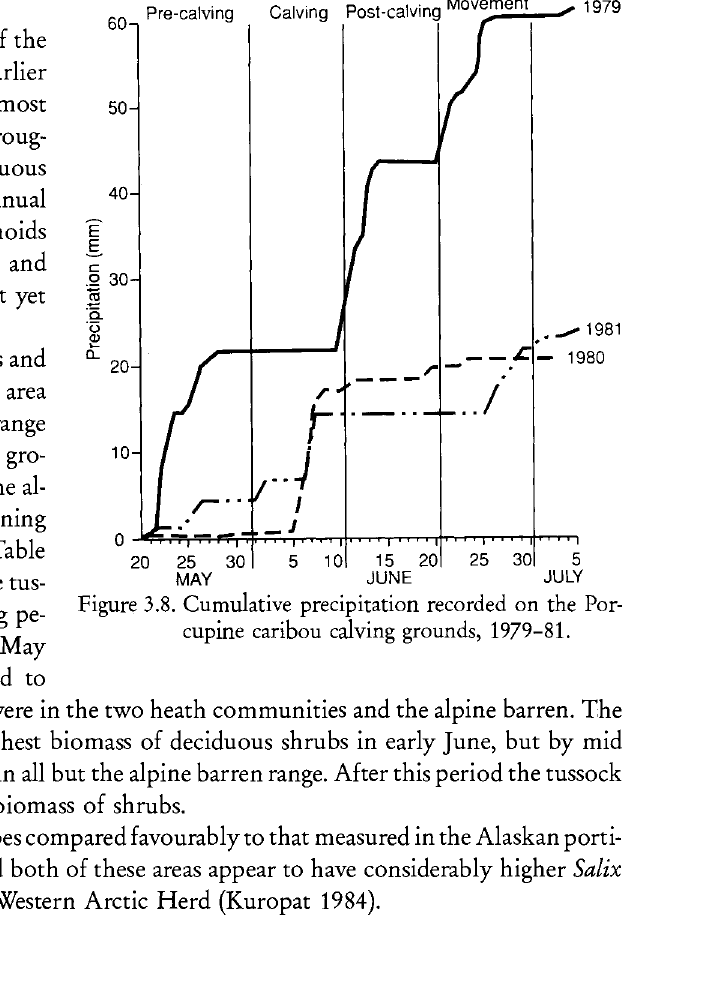
Figure 3.8. Cumulative precipitation recorded on the Por